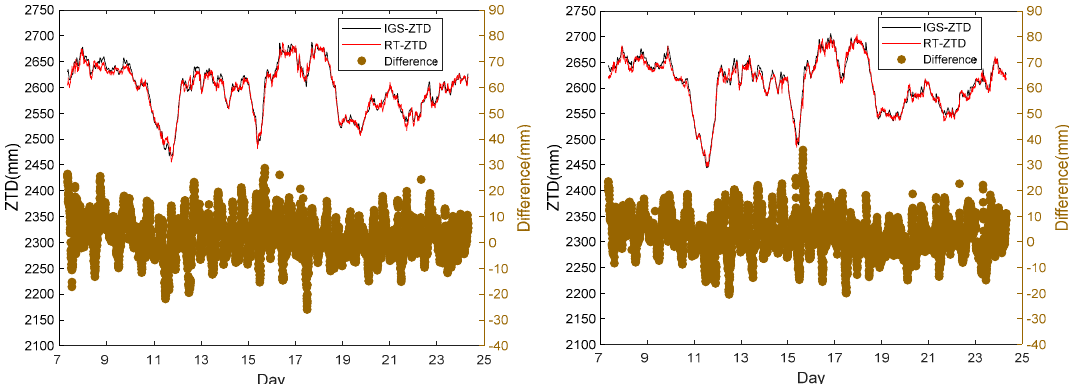
Figure 2. Comparison of real-time zenith total delay (RT-ZTD) and international GNSS (global navigation satellite systems) service (IGS)-ZTD over two stations HKSL ( left ) and HKWS ( right ) during the period of 7–25 September